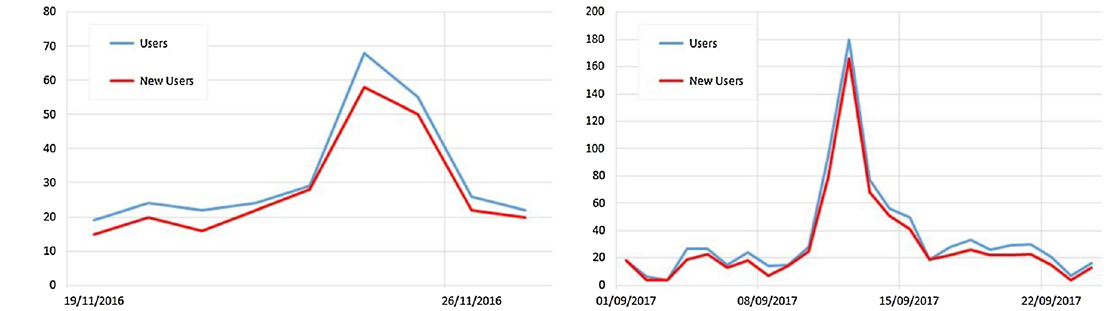
Table 3 #italiasicura data on the number of new users, new sessions, the number of pages per session, and the duration of the sessions for a selected number of Italian cities in the period 14 April 2015–13 December 2015 City New users Pages/session Average session duration